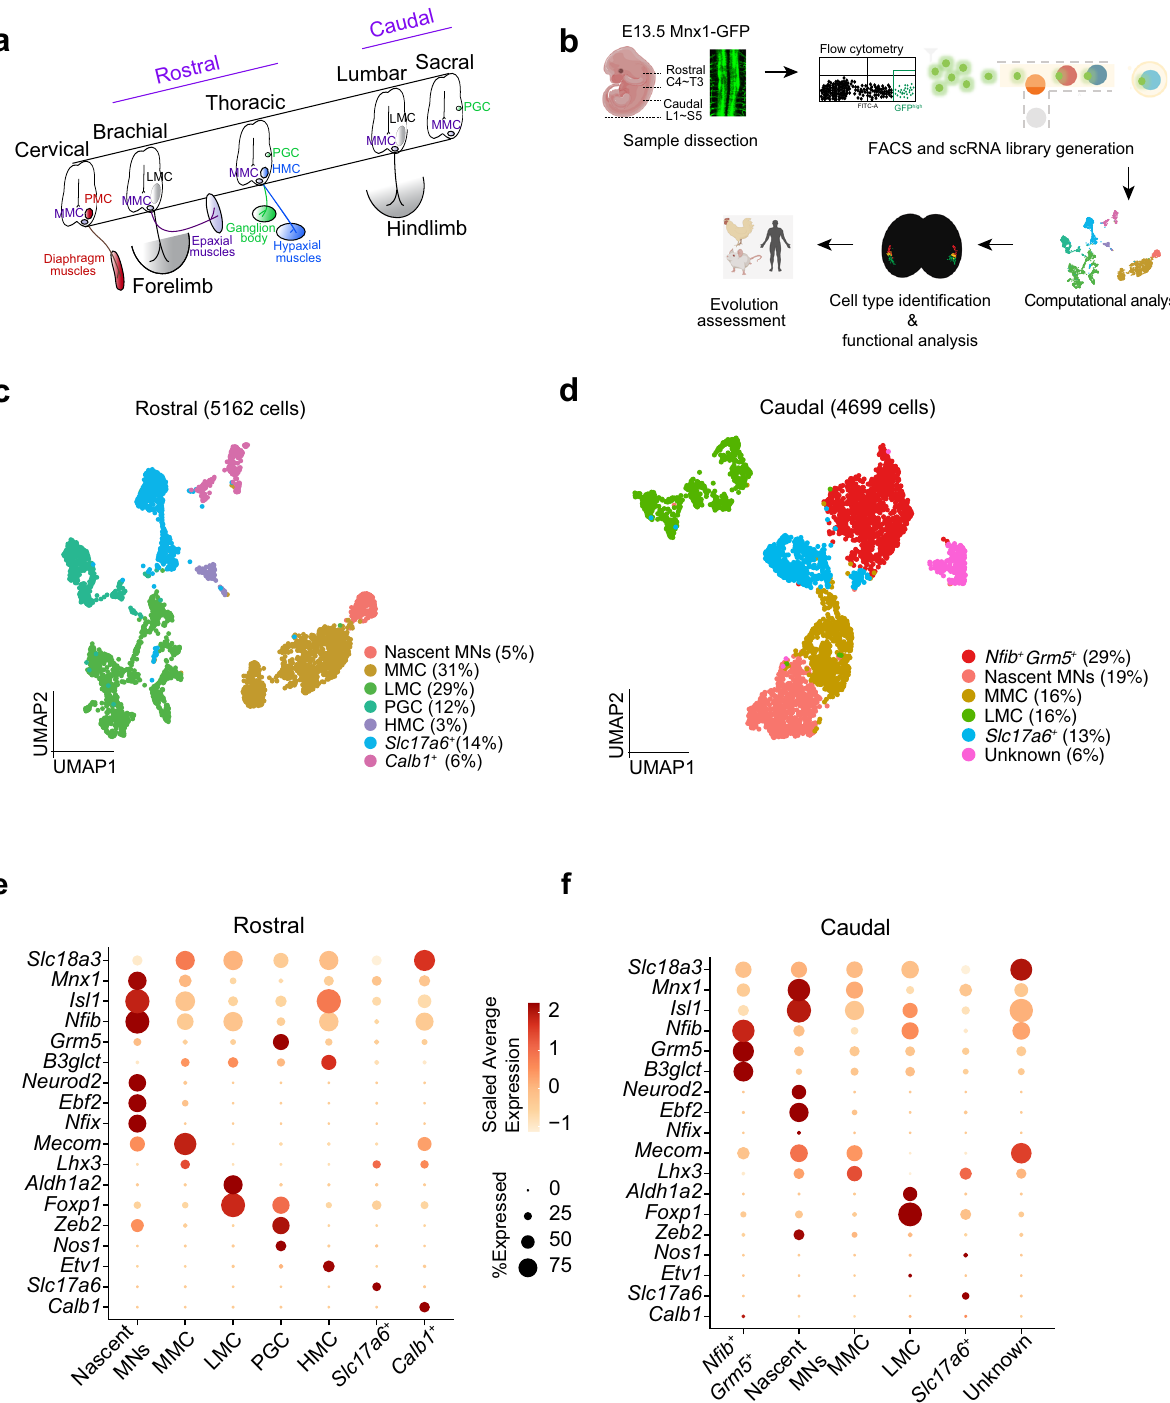
Fig.1|Single-celltranscriptomepro fi lingofE13.5mousespinalmotorneurons. a Illustration of MN subtypes innervating different muscle targets along the ros- trocaudal axis of the spinal cord. Innervation targets and motor column are coded with the same color: PMC phrenic motor column (red), MMC medial motor col- umn (violet), LMC lateral motor column (grey), PGC preganglionic motor col- umn (green), HMC hypaxial motor column (blue). Samples for this study were collected from rostral and caudal segments. b Overview of the experimental work fl ow. c , d UMAPplots showing cellularheterogeneity of c rostraland d caudal samples after removing interneuron and non-neuronal cells. Cell populations are color-coded, and cell identities have been annotated based on the expression